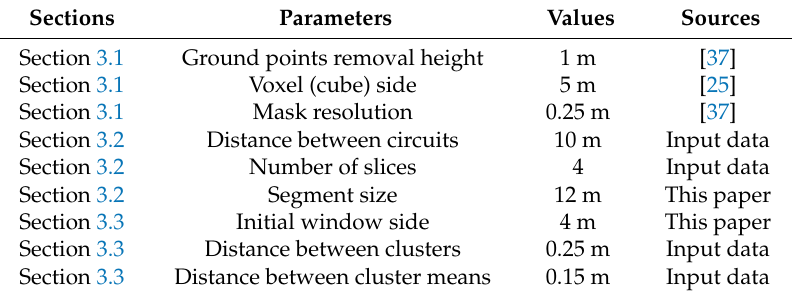
Table 3. Parameter values used in the proposed